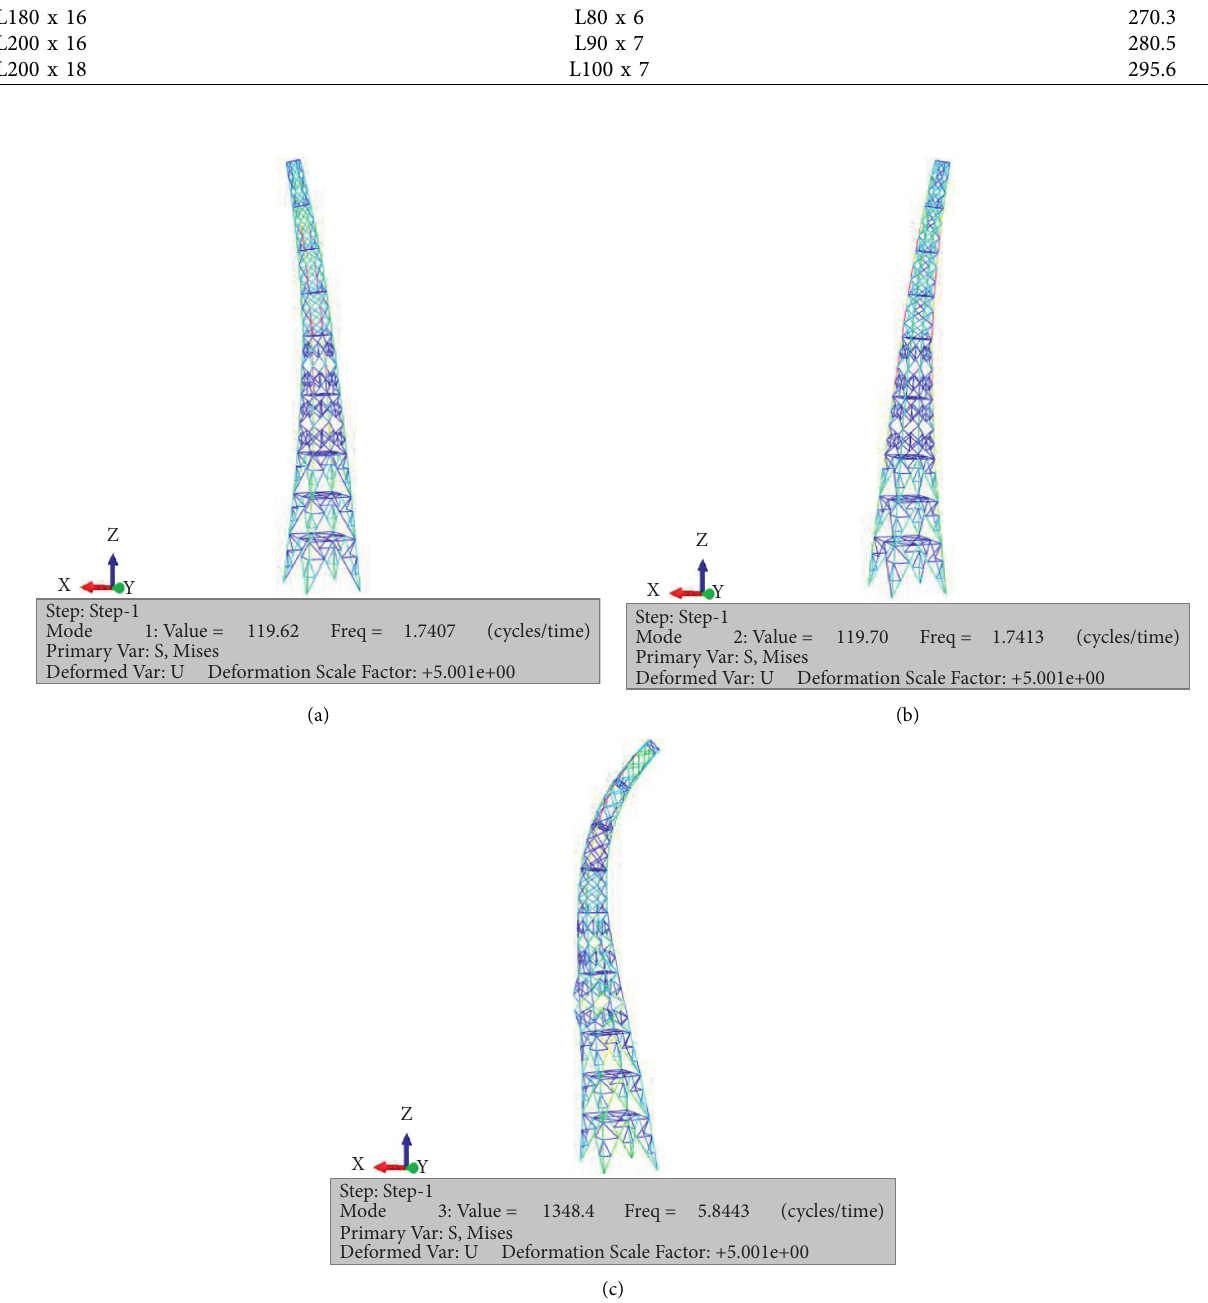
Figure 2: Mode shapes of (a) first order, (b) second order, and (c) third